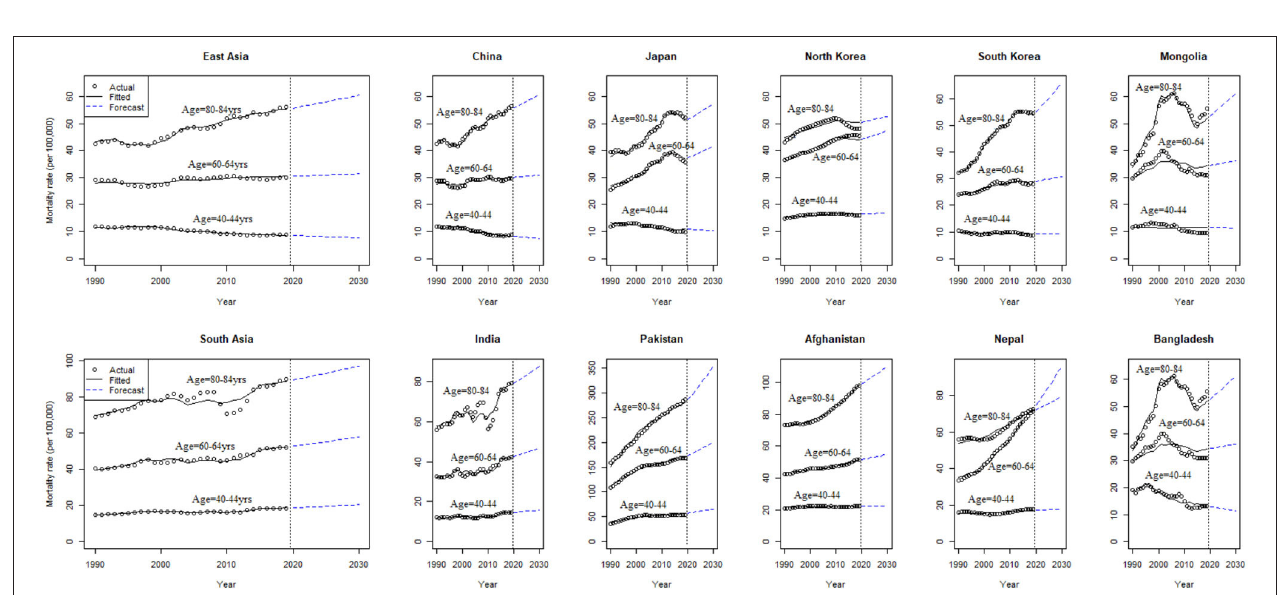
FIGURE 2 | Age-specific observed, estimated, and predicted breast cancer mortality rates (per 100k) from 1990 to 2030, at the regional and national level of East and South Asia.